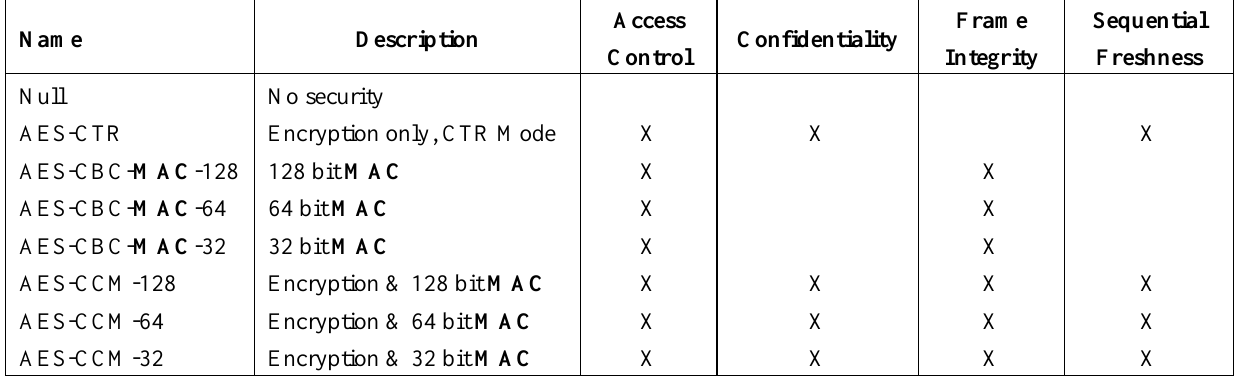
Table 2. Security modes in IEEE